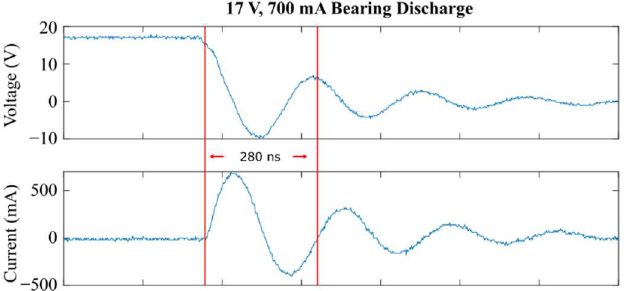
Figure 5. A 17 V, 700 mA discharge measured experimentally at a discharge frequency of 10.33 MHz.